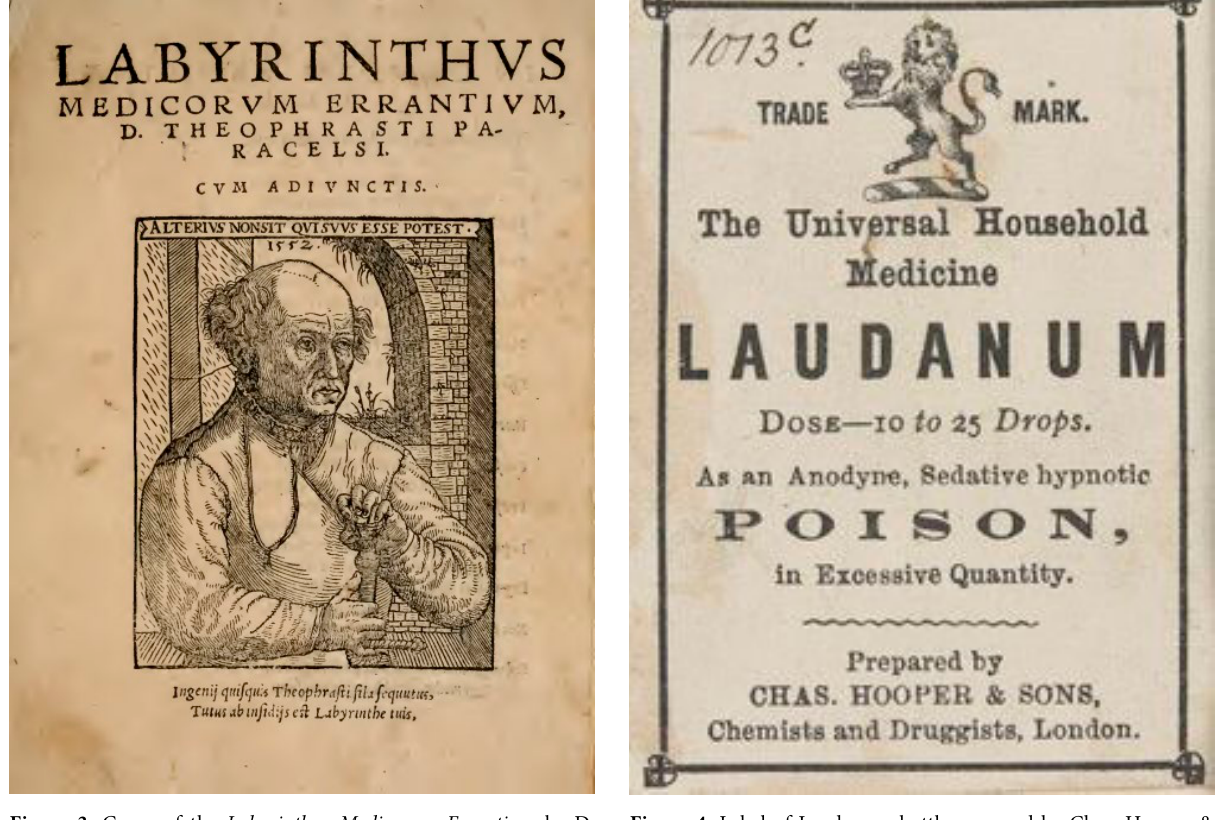
Figure 3. Cover of the Labyrinthus Medicorum Errantium by D. Theophrasti Paracelsi.